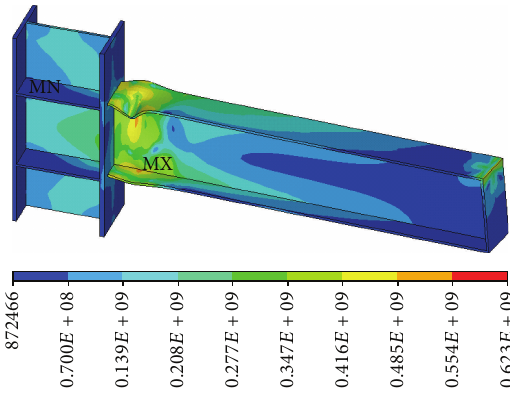
Figure 7: Stress of traditional beam-column connection.